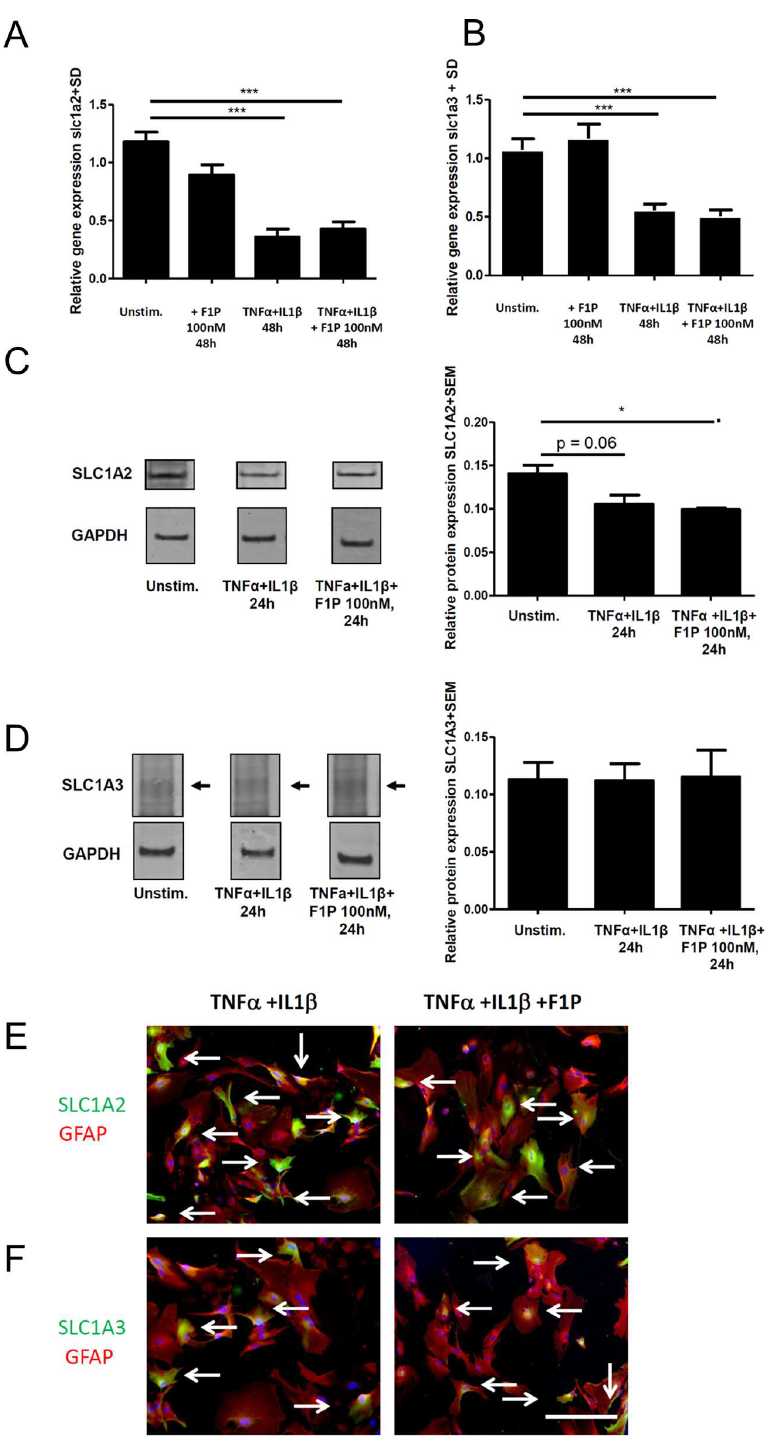
Fig 1. Effects of fingolimod-1 phosphate on glutamate transporter mRNA and protein levels in astrocyte cell culture. RT-PCR analysis of (A) slc1a2 expression or (B) slc1a3 expression after astrocyte culture for 12 days and 48 hours of stimulation with TNF- α (100 U/ml) and IL-1 β (10 ng/ml) versus na ï ve controls and with our without addition of F1P at 100 nM, n = 17/3/9/14 per group. (C,D) Western Blot analysis of (C) SLC1A2 protein expression or (D) SLC1A3 protein expression in astrocytes cultured for 12 days either as na ï ve cells or after stimulation with 100 U/ml TNF- α and 10 ng/ml IL-1 β for 48 hours with or